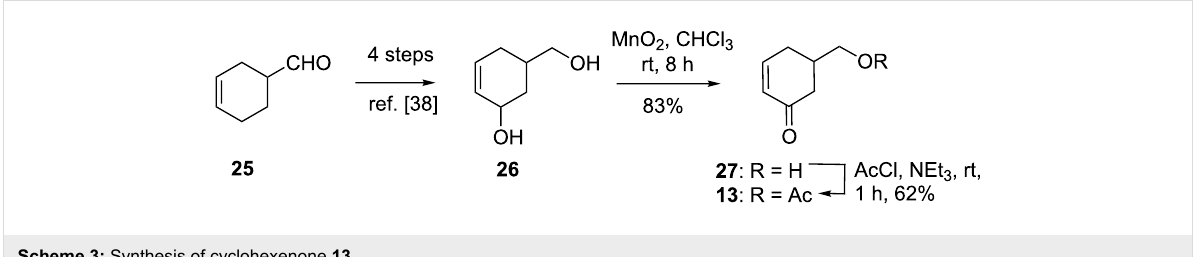
Scheme 3: Synthesis of cyclohexenone 13